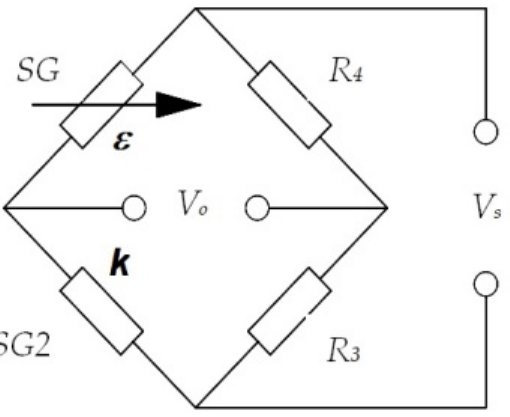
Figure 9. Wheatstone quarter bridge with active SG and compensation SG2 strain gauge.